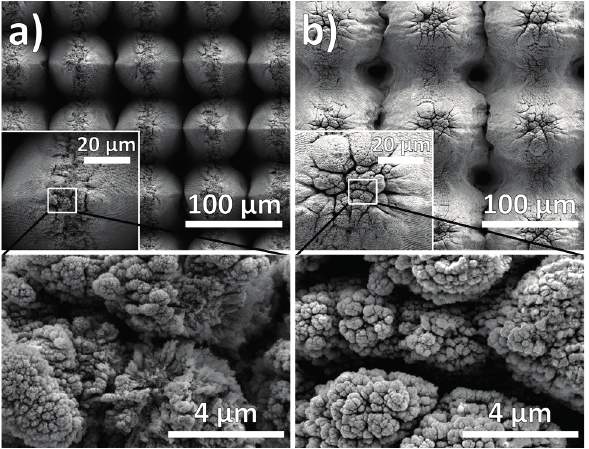
Figure 10. SEM micrographs of: ( a ) pyramid structures and ( b ) column structures on Cu. Inset: magnified view showing the hierarchical nature of the structures.